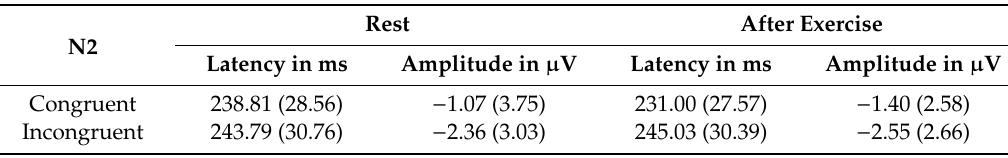
Table 3. Mean (SD) N2 peak latencies and amplitude for congruent and incongruent conditions at rest and after exercise at electrode site Fz.